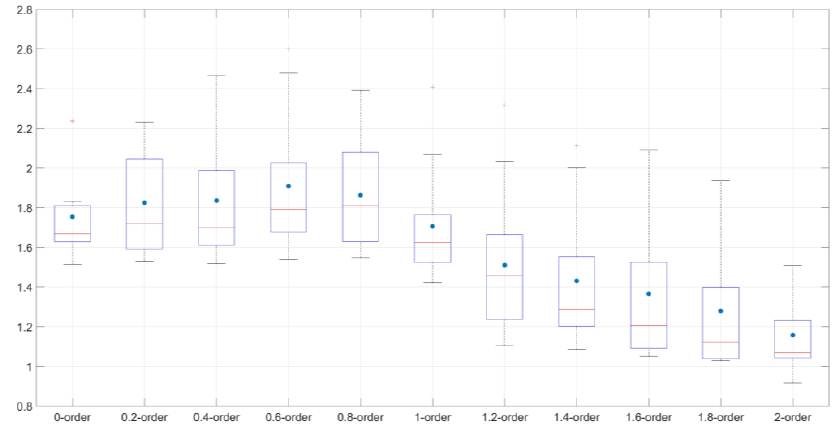
Figure 5. Boxplot of the RPD versus soil organic matter content estimation models using fractional